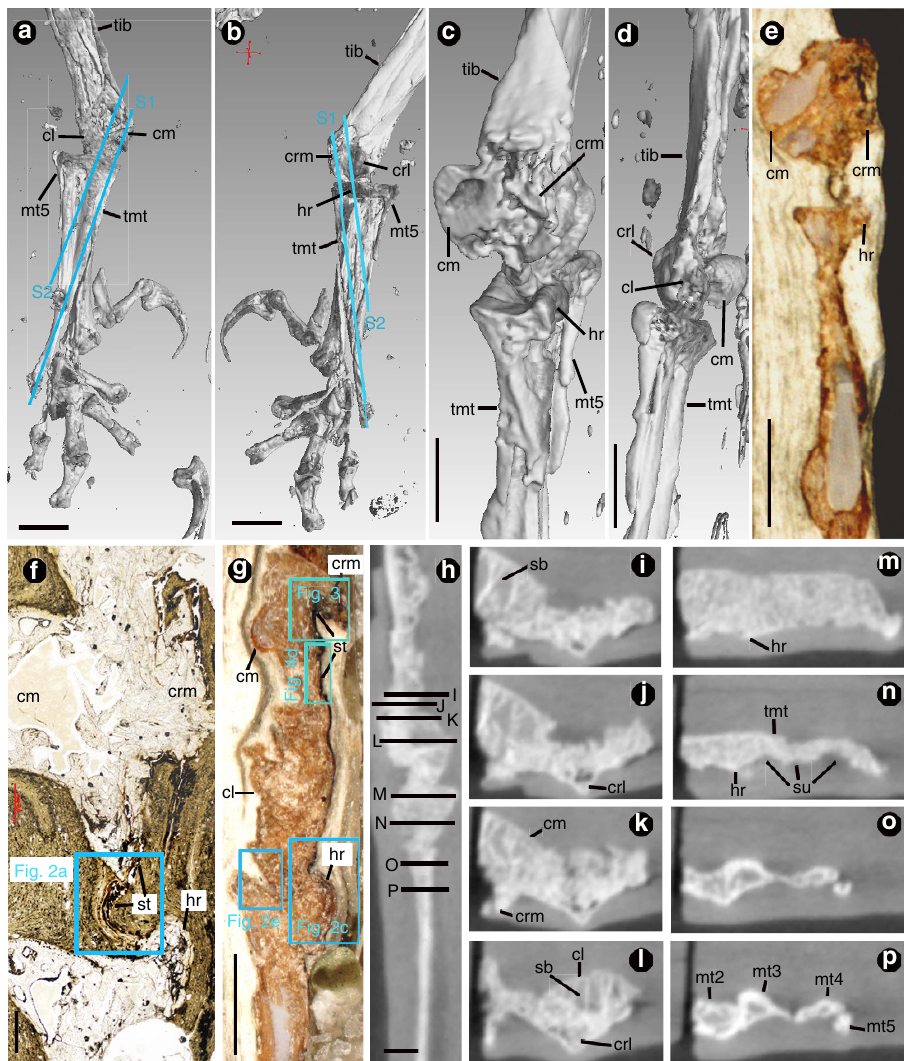
Figure 1 | Osteology and putative soft tissues of the Confuciusornis hindlimb. Specimen MES-NJU 57002 (right lower limb), showing position of sections. ( a , b ) Three-dimensional digital images, constructed from microCTscan data, showing approximately dorsal ( a ) and plantar ( b ) views of the right distal hindlimb and positions of sections. ( c , d ) Close-up view of the ankle joint in approximately medial ( c ) and lateral ( d ) views. ( e – g ) Photomicrographs of the ankle joint before sectioning ( e ), in section 1 ( f ), and in section 2 ( g ). ( h ) Approximately sagittal microCT slice showing positions of horizontal microCT slices. ( i – p ) Continuous horizontal microCT slices across the distal tibiotarsus ( i – l ) and proximal tarsometarsus ( m – p ). cl, condylus lateralis; cm, condylus medialis; crl, crista lateralis; crm, crista medialis; hr, hypotarsal ridge; mt, metatarsal; S1/S2, sections 1/2; sb, spongy